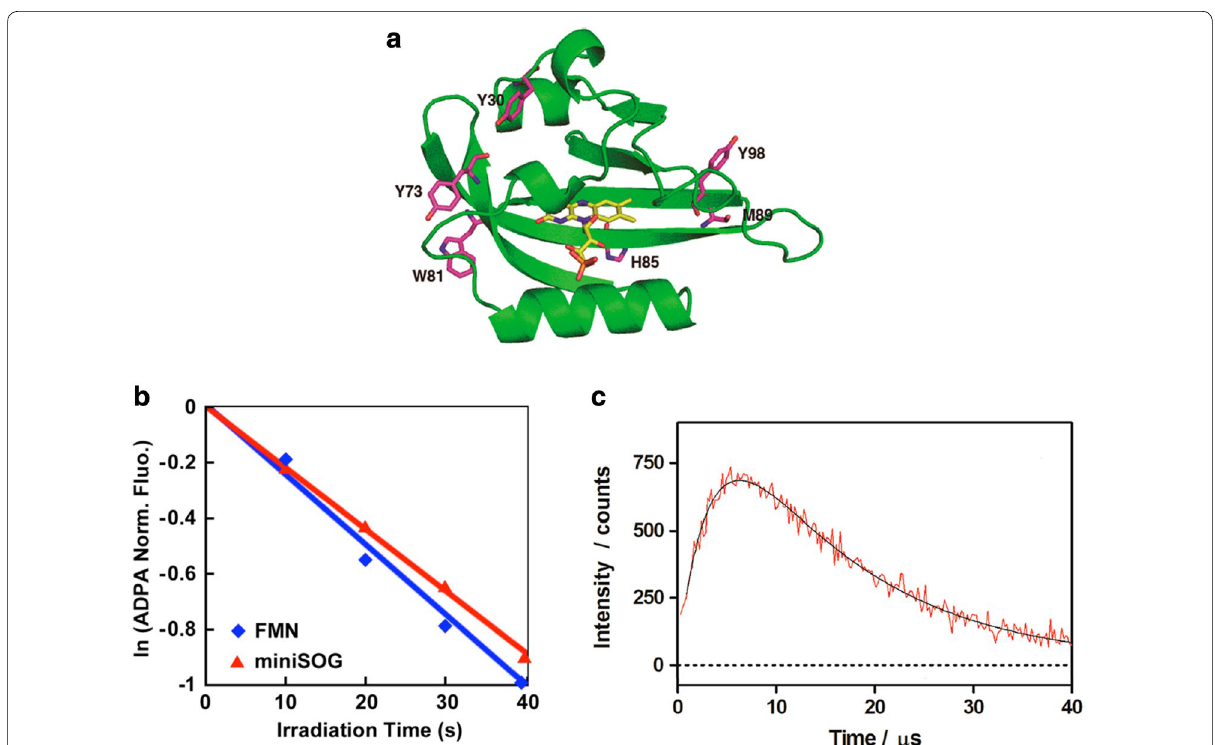
Fig. 4 a 3D structure of miniSOG. This molecular model is based on the structure of the improved LOV protein (PBD ID: 4eet) using the Swiss‑model server [83]. The backbone of miniSOG is shown as the green ribbon, flavin mononucleotide (FMN) as the orange sticks, and the amino acids as the magenta sticks (Reproduced from [65] with the permission of American Chemical Society). b Degradation of ADPA reacted with 1 O 2 photogen‑ erated by miniSOG under light irradiation (red) (Figure from [64] and Creative Commons license). c Photosensitized 1 O 2 formation from miniSOG.